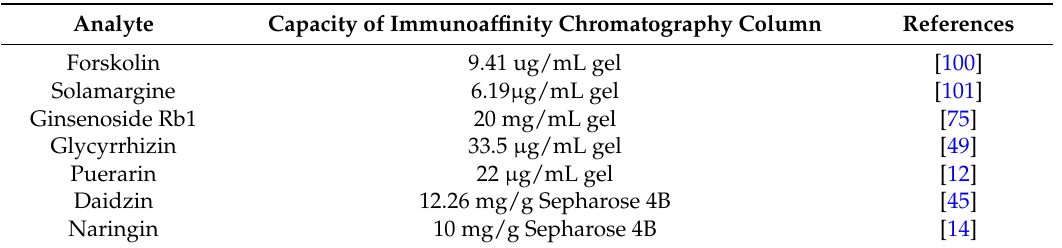
Table 5. The conjugate capacity between anti-MPNP MAbs and the carriers of the immunoaffinity (IA)